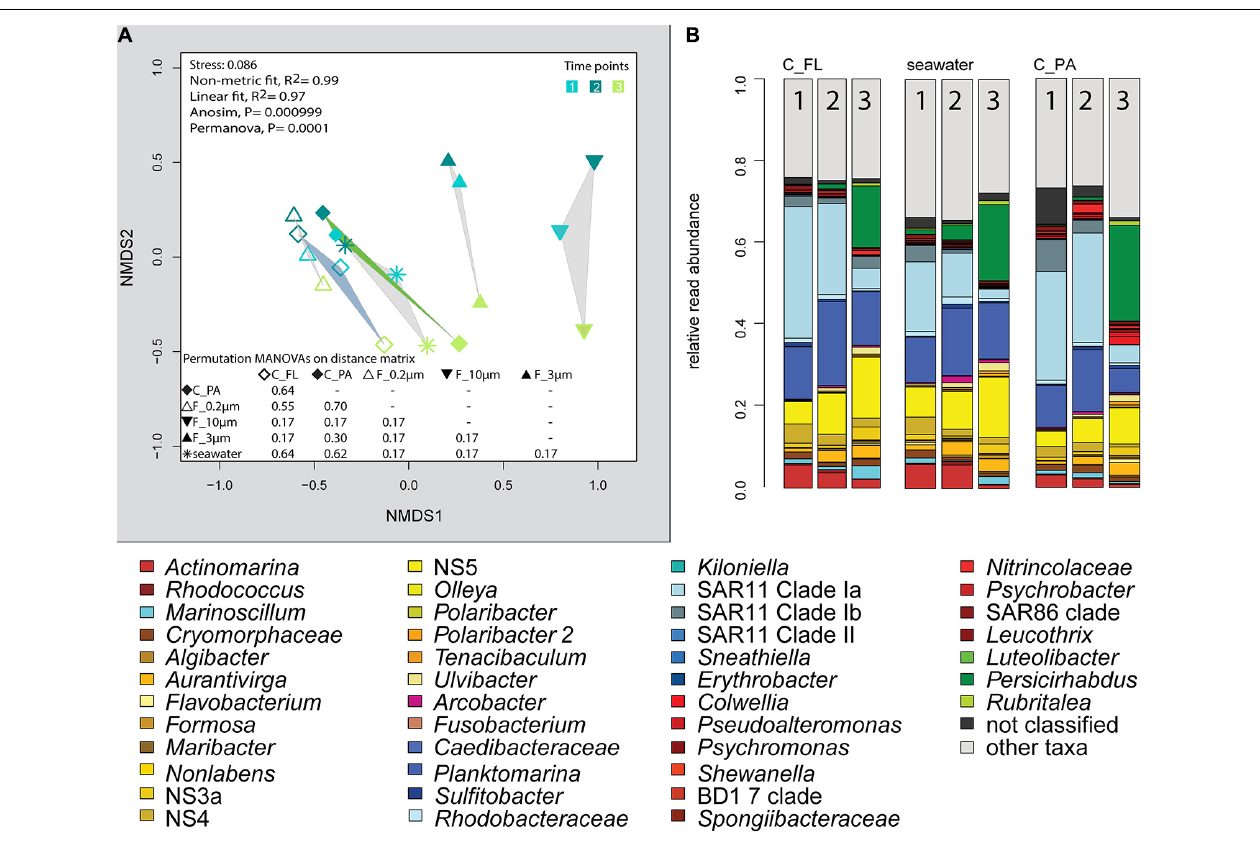
FIGURE 5 | Bacterial community diversity of unfractionated seawater, density-, and size-fractionated populations obtained during a phytoplankton spring bloom off Helgoland (North Sea) in 2018. (A) Non-metric multidimensional scaling (NMDS) plot based on Bray–Curtis dissimilarity shows shifts in bacterial communities at three sampling time points (Julian Days 102, 109, and 115). The statistical evaluation is represented by an ANOVA, PERMANOVA, and a pairwise comparison visualized in a distance matrix (n for each group: 3). (B) Stacked bar charts of community composition. Operational taxonomic units (OTUs) shown were among the five most abundant OTUs in at least one sample. C_FL , supernatant fraction of a separation by centrifugation (with free-living cells); C_PA , particle fraction of a separation by